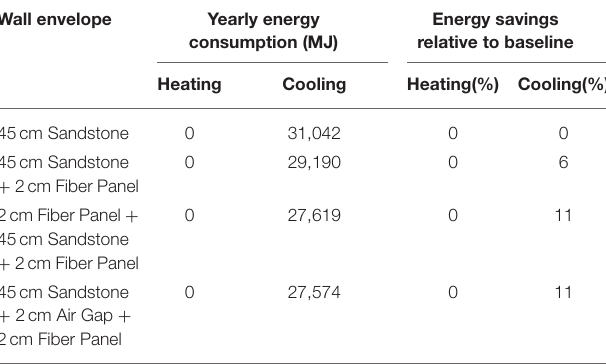
TABLE 5 | EnergyPlus model results for the case of Bhuj, India using adjusted wall envelope. Wall